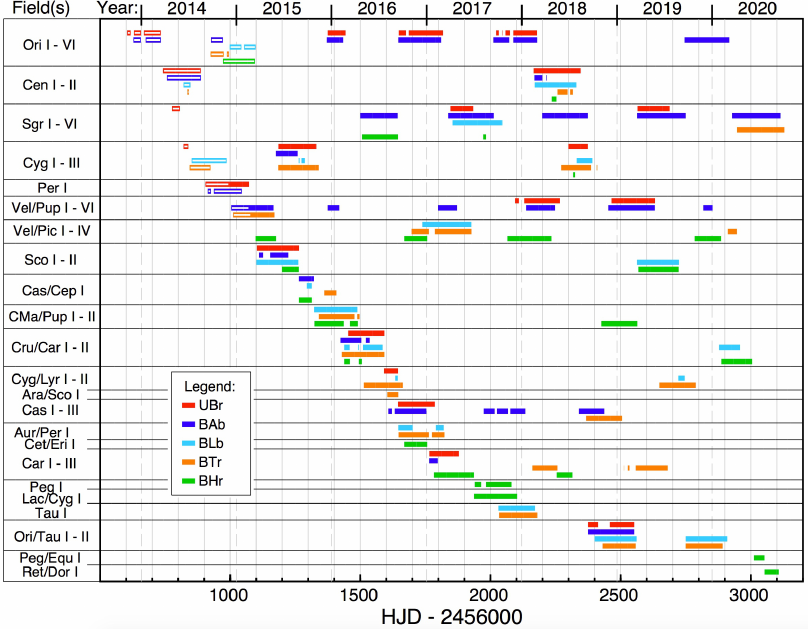
Figure 10. Temporal distribution of the observations of all five active BRITE satellites until the end of 2020. The data obtained in the stare and chopping observing modes are shown with unfilled and filled bars,